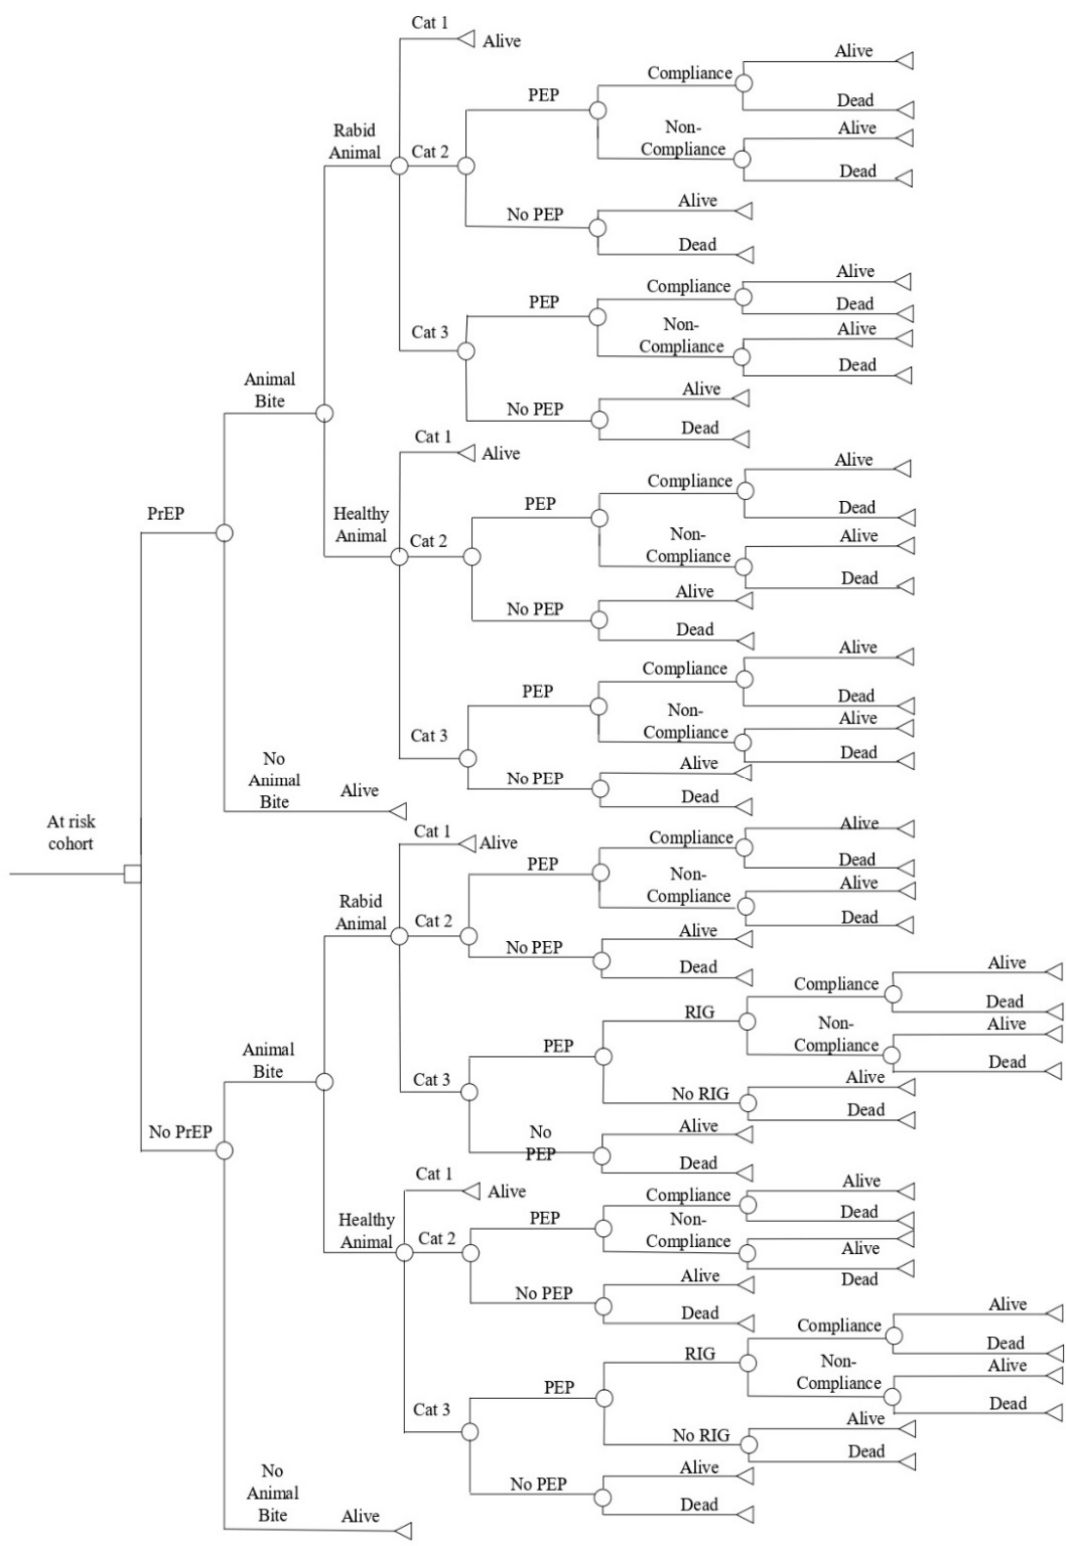
Figure 1. Decision Tree Model. Cat 1—Category 1, Cat 2—Category 2, Cat 3—Category 3, PEP—Post- Exposure Prophylaxis, PrEP—Pre-Exposure Prophylaxis, RIG—Rabies